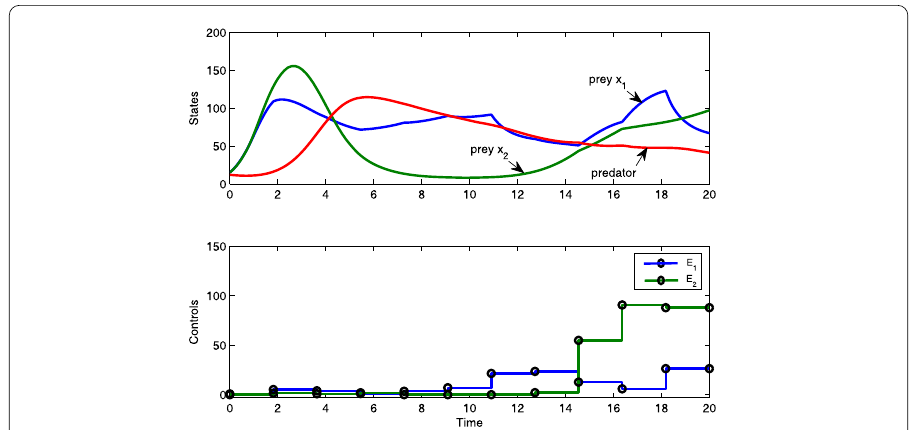
Figure 8 The optimal states and control of problem